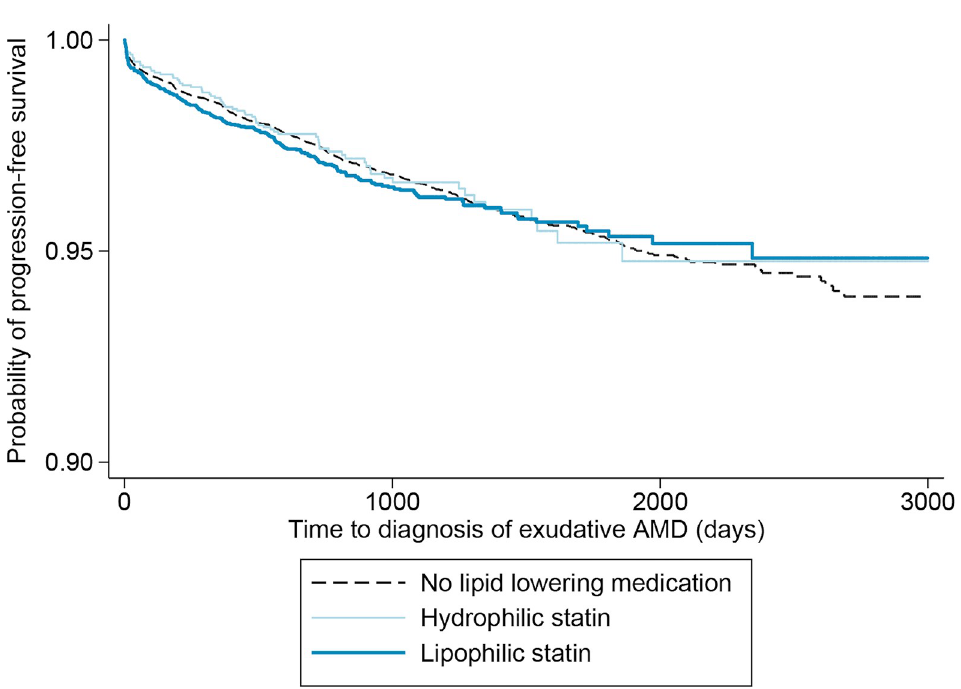
Fig 3. Time to progression from non-exudative to exudative age-related macular degeneration (AMD) by class of statin.